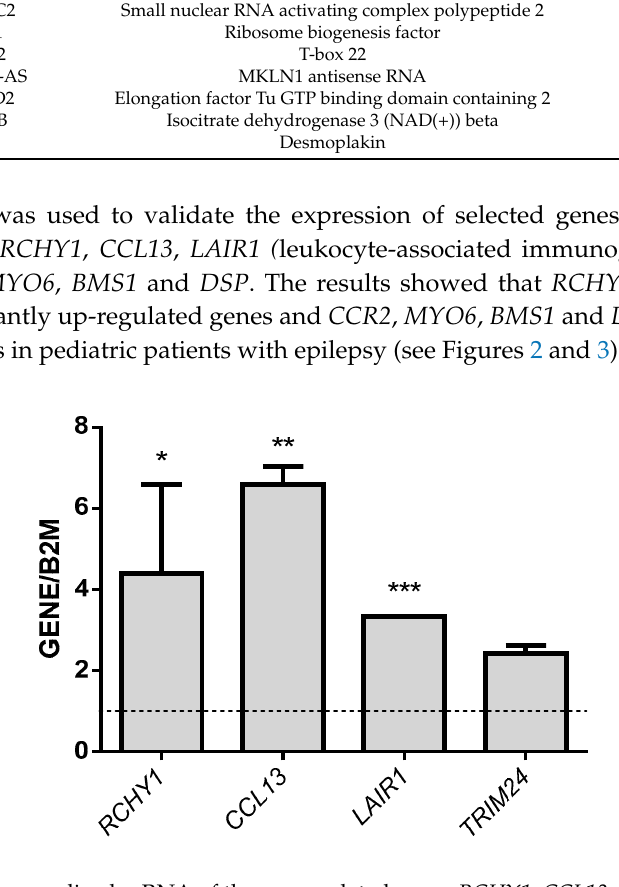
Figure 2. Levels of normalized mRNA of the up-regulated genes RCHY1 , CCL13 , LAIR1 and TRIM24 in pediatric patients with epilepsy. The gene levels were normalized to the level of the housekeeping gene B2M and are expressed per 20 ng of total RNA. The values represent the means with standard deviations (SD) of the expression levels of each gene. We found significant differences between all genes. * p < 0.05 vs. the gene expression of CCL13 , LAIR1 , and TRIM24 ; ** p < 0.05 vs. the gene expression of LAIR1 and TRIM24 ; and *** p < 0.05 vs. the gene expression of TRIM24 .